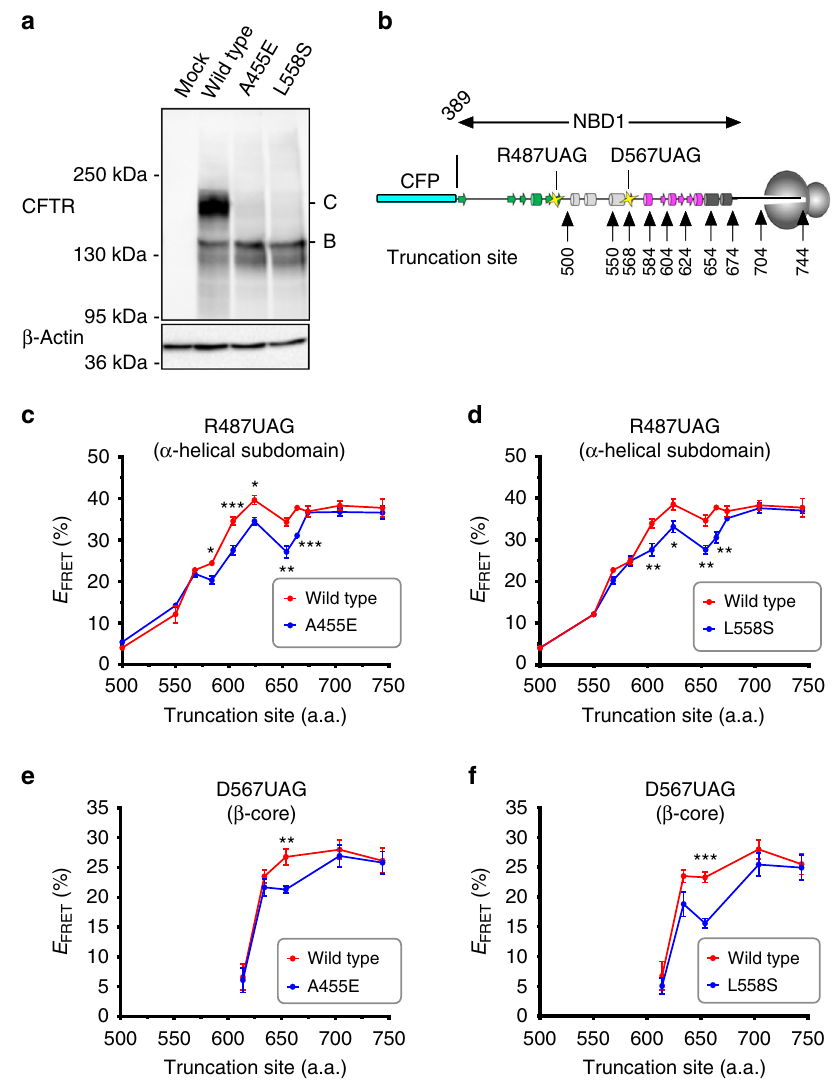
Fig. 2 A455E, L558S transiently disrupt NBD1 cotranslational folding. a Immunoblot of full-length CFTR (wild-type, A455E, or L558S) expressed in human embryonic kidney (HEK) 293 cells showing core glycosylated (band B) and mature CFTR (band C). Uncropped blots in Source Data. b Schematic of ribosome-attached CFP-NBD1 showing approximate location of acceptor dye incorporation sites (residue Arg487 or Asp567) and truncation sites used in c – f . c – f Length-dependent FRET ef fi ciencies for wild-type (red line) and A455E or L558S (blue line) obtained from ribosome-attached CFP-NBD1 constructs with acceptor dye located at R487UAG c , d or D567UAG e , f for each truncation site indicated. Data are mean ± SEM, n ≥ 3 independent experiments. Two-tailed student ’ s t test comparing wild-type and A455E or L558S, asterisk p < 0.05, double asterisk p < 0.01, triple asterisk p < 0.001, n.s. > 0.05 otherwise indicated. Note that wild-type data for truncation sites 500, 568, 584, and 664, and A455E data for truncation sites 500, 550, 568, 664 shown in c , and wild-type data for truncation sites 500, 550, 568, 584, and 664, and L558S data for truncation site 664 shown in d have error bars smaller than the dots. Some data for truncation sites 568, 604, 654, 666, 704, and 744 shown in c , d are also taken from Figs. 1d, 3a, b, 4a, b, & 5b. Source data of a , c – f are provided as a Source Data fi